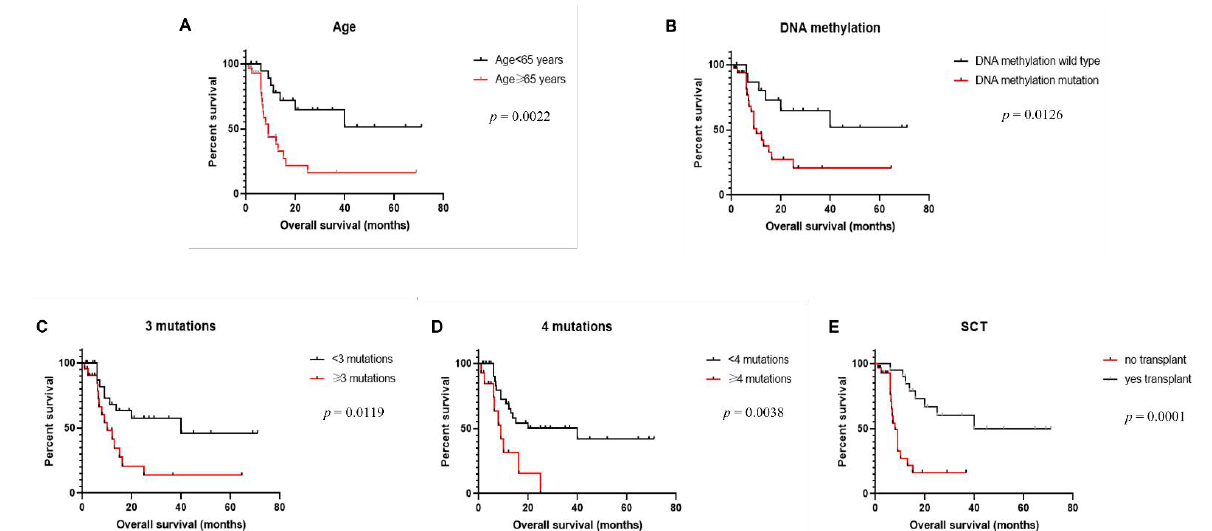
Figure 3. Overall survival of patients with blastic plasmacytoid dendritic cell neoplasm. ( A ) Comparison between patients ≥ 65 years and <65 years of age. ( B ) Comparison between patients with and without mutations affecting DNA methylation pathway. ( C ) Comparison between patients with <3 vs. ≥ 3 mutations. ( D ) Comparison between patients with <4 vs. ≥4 mutations. ( E ) Comparison between patients who did and those who did not receive hematopoietic stem cell transplantation (SCT).